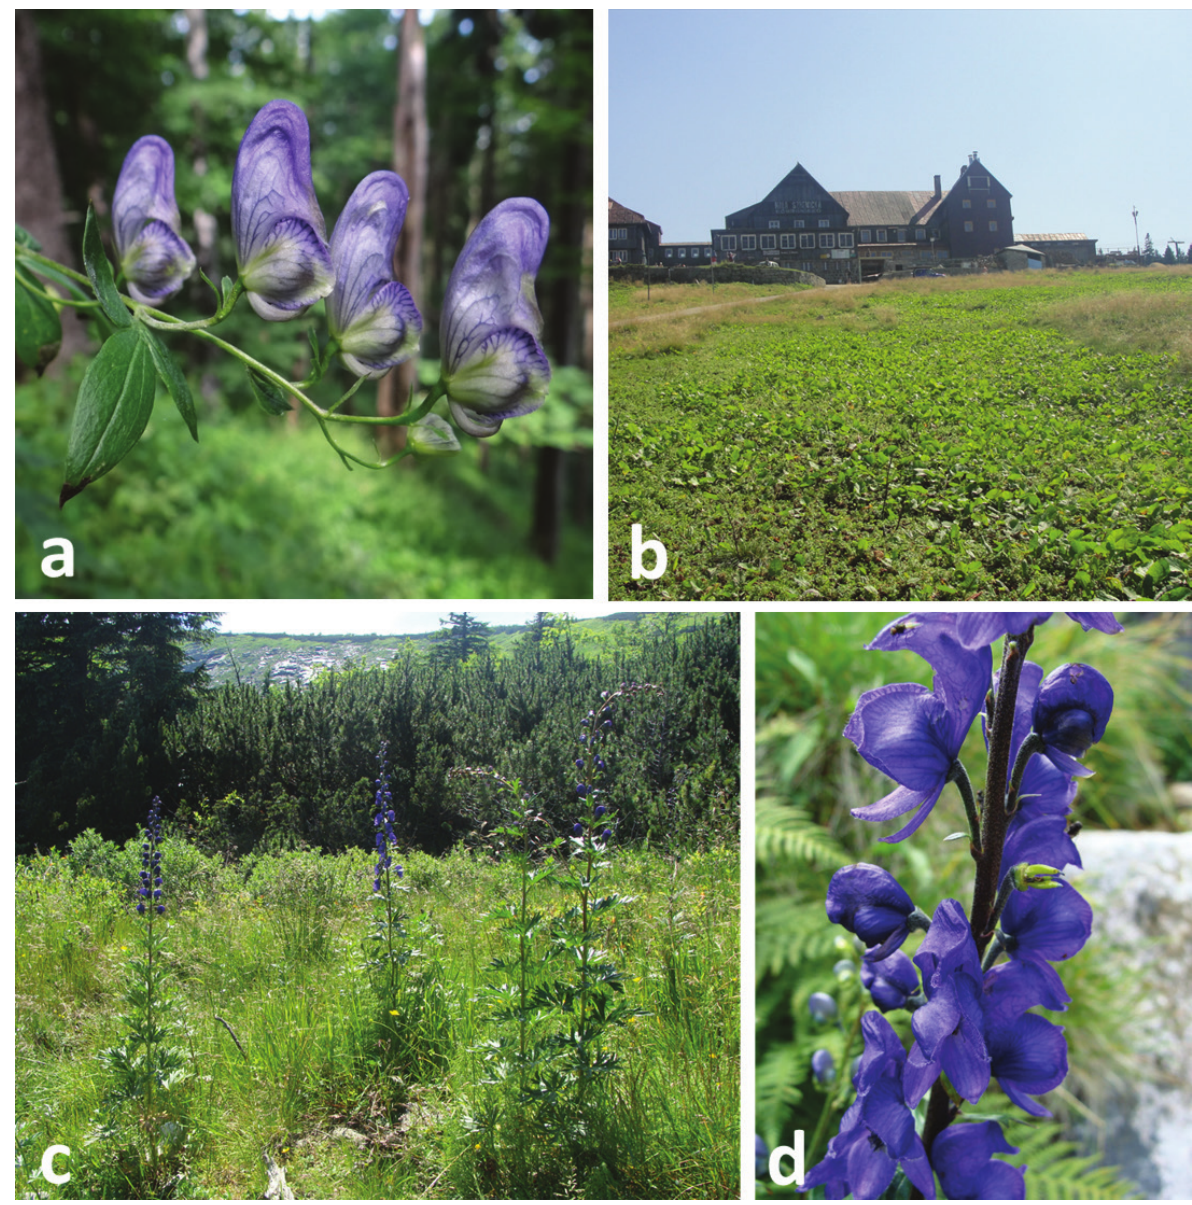
Figure 5. Communities of Mulgedio-Aconitetea in the Karkonosze Mts. and Orlickie Mts. a. Aconitum variegatum in the Athyrietum filicis-feminae in the Orlickie Mts. near Zieleniec; b. Rumicetum alpini in the vicinity of Hala